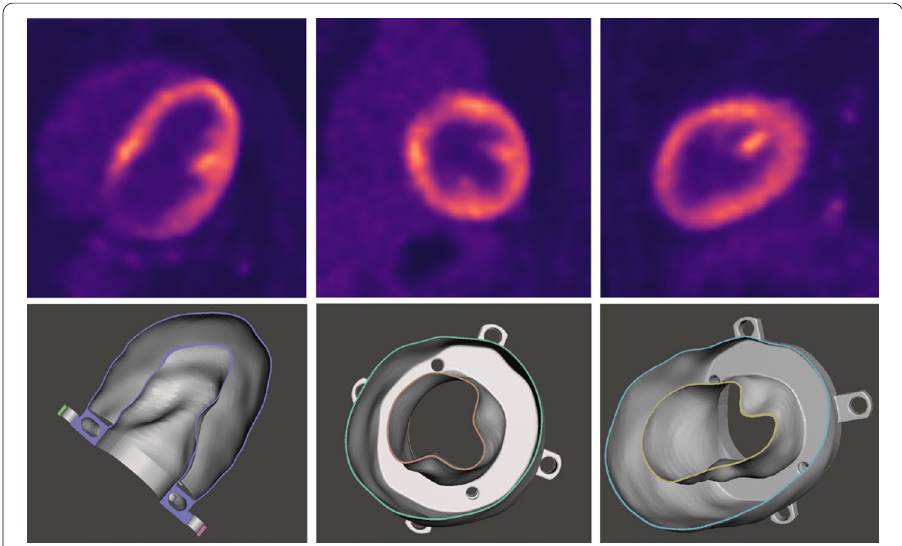
Fig. 1 Three orthogonal views of reconstructed 18 F-FDG PET/CT image (upper row) and the 3D phantom design (bottom